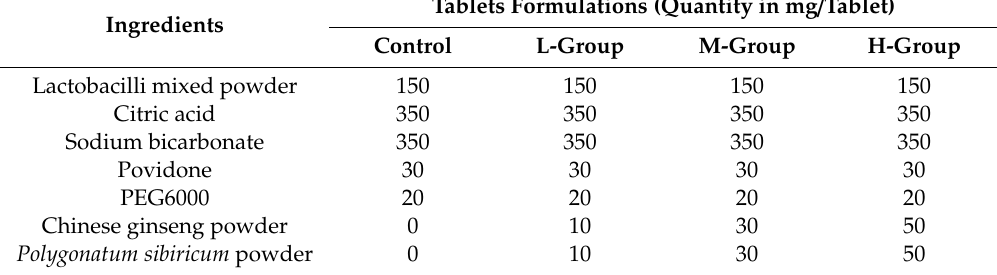
Table 1. Formulations of lactobacilli e ff ervescent tablets supplemented with di ff erent contents of Chinese ginseng and Polygonatum